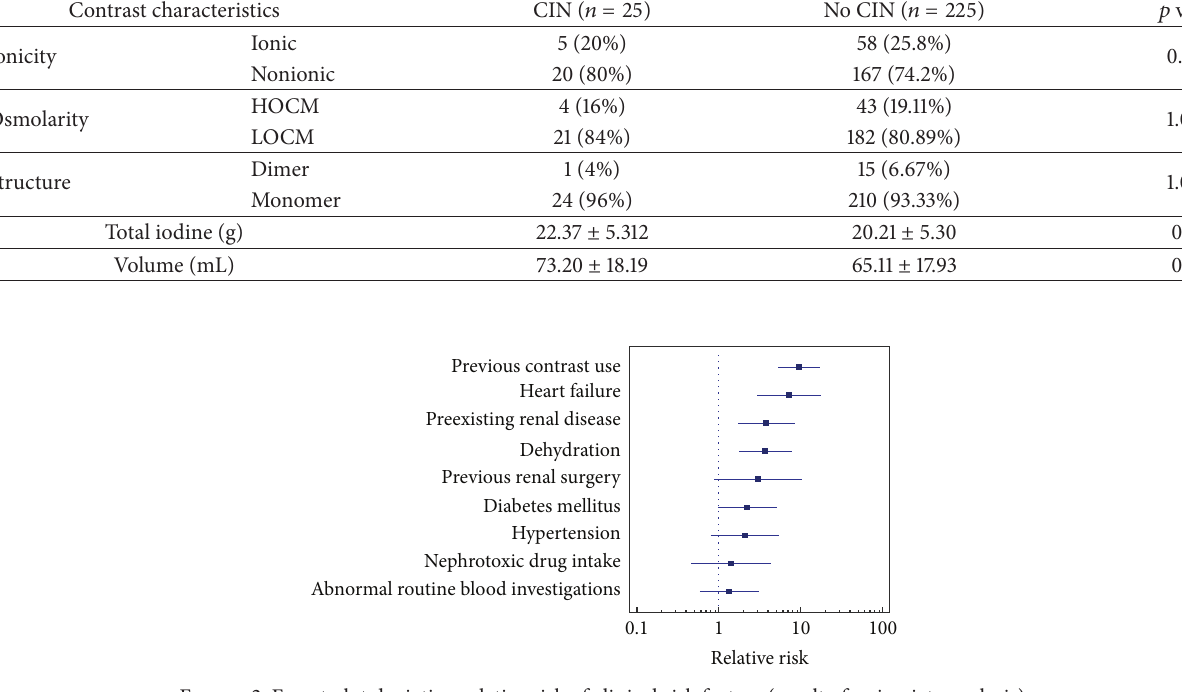
Figure 2: Forest plot depicting relative risk of clinical risk factors (result of univariate